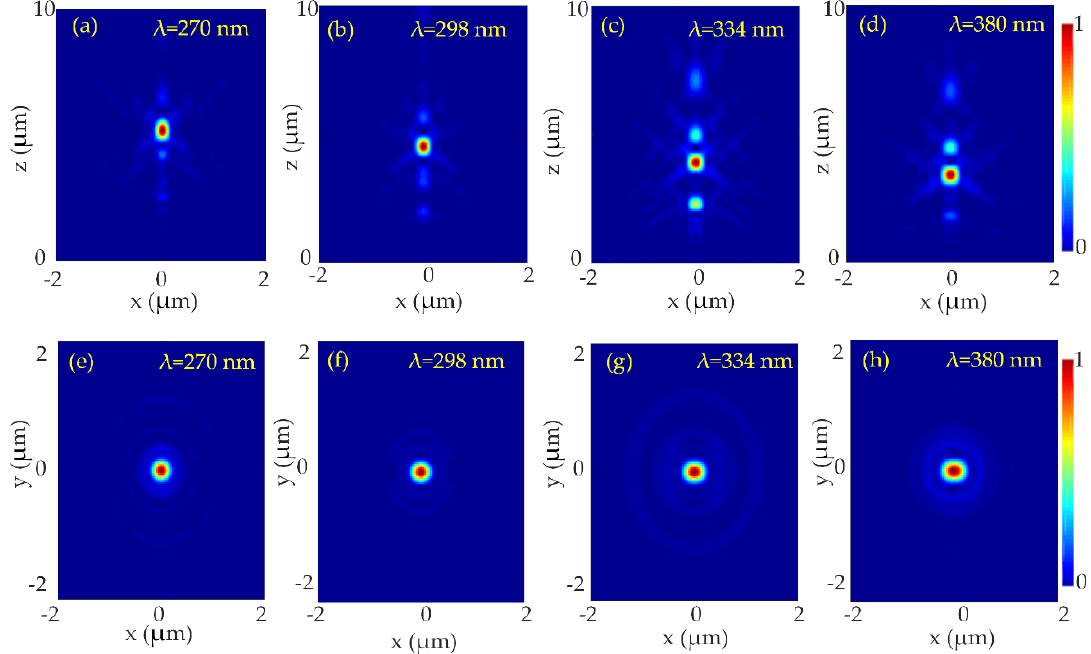
Figure 3. Normalized intensity distribution of the designed UV metalens at incident UV light 270–380 nm at the x - z plane. ( a ) λ = 270 nm, ( b ) λ = 298 nm, ( c ) λ = 334 nm ( d ) λ = 380 nm. The NA of the metalens at designed wavelength λ d = 290 nm is 0.86. Normalized intensity distribution of the designed UV metalens at incident UV light 270–380 nm at the x-y plane at x = y = 0. ( e ) λ = 270 nm, ( f ) λ = 298 nm, ( g ) λ = 334 nm ( h ) λ = 380 nm. The NA of the metalens at designed wavelength λ d = 290 nm is 0.86.